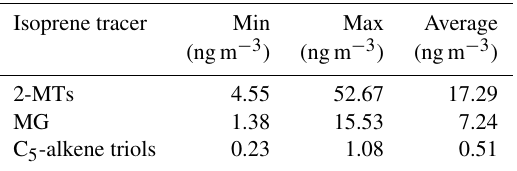
Table 3. Isoprene CHO tracer concentrations measured via GC- MS using 24h samples between 22 May and 22 June 2017. 2- MTs is equal to the sum of 2-methylthreitol and 2-methylerythritol, and the C5-alkene triols are equal to the sum of cis -2-methyl- 1,3,4-trihydroxy-1-butene, 3-methyl-2,3,4-trihydroxy-1-butene and trans -2-methyl-1,3,4-trihydroxy-1-butene. Isoprene tracer